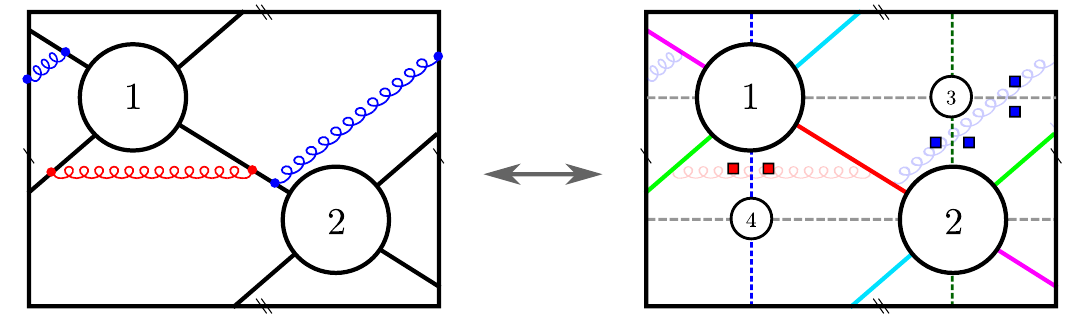
Figure 14 . We represent the torus as a square, and consider a two-point function in the tessellation of section 5.1. By the intuition developed in section 6.5, attaching a YM line to a strand of propagators should have an interpretation in terms of virtual magnons. For the usual planar wrapping interactions, this appears straightforward in the spirit of (cid:12)gure 13. In the case of exchanges that go around the torus’ cycles | in (cid:12)eld theory, a YM line passing through the sphere | we expect multi-magnon wrapping to appear. This is not surprising, as all dotted lines in the (cid:12)gure are zero-length